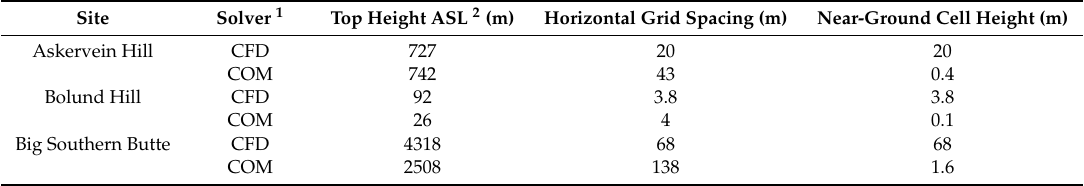
Table 3. Computational mesh characteristics.